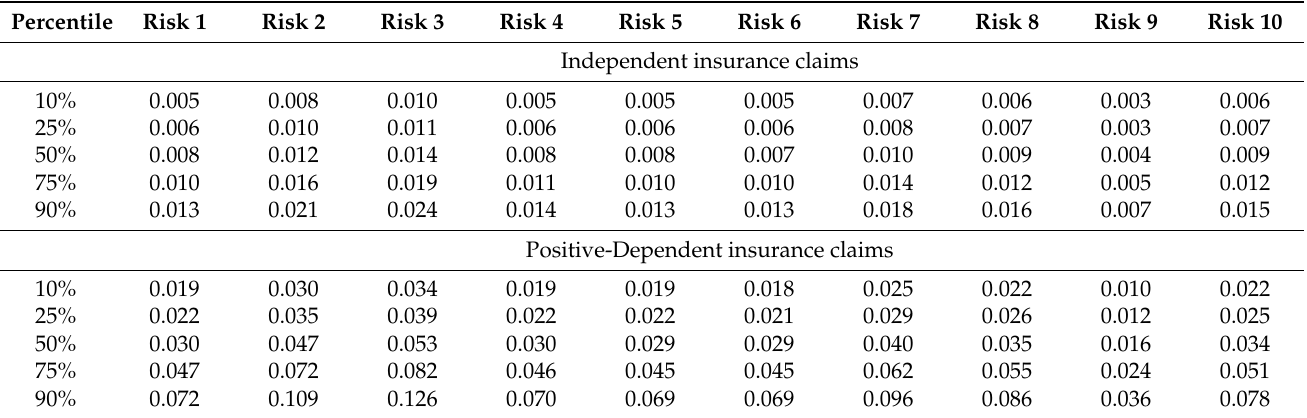
Table 2. SRRM for independent and positive-dependent reinsurance